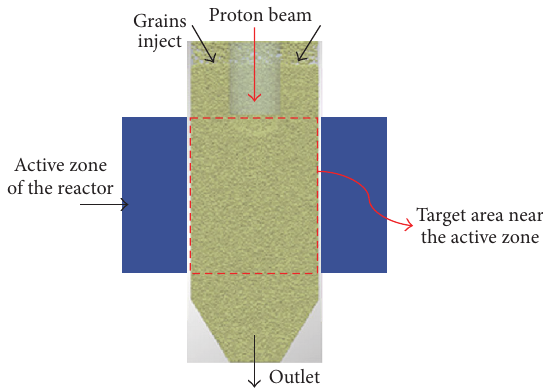
Figure 3: Schematic of the whole computational model.